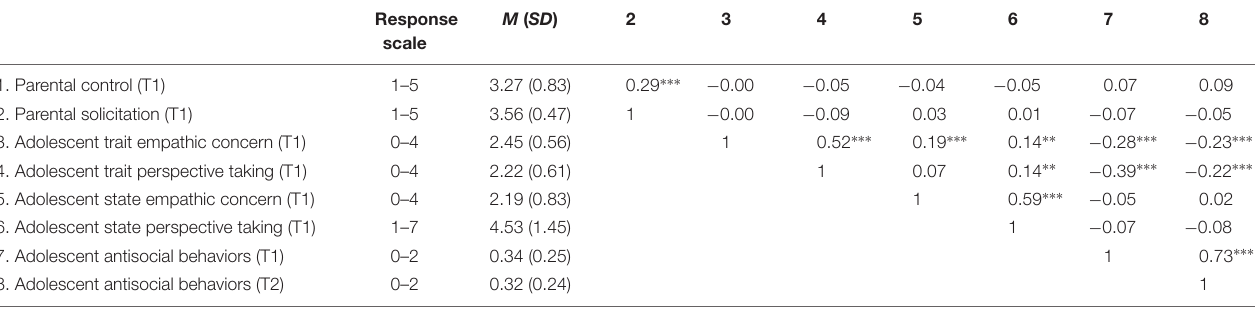
TABLE 1 | Descriptive statistics and bivariate correlations among study